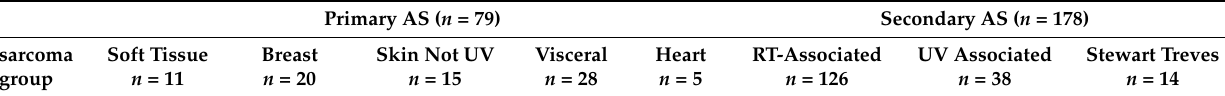
Table 3. Immune densities for all AS subgroups. Cell densities are reflected in cells/mm 2 with the IQR for all individual immune cell subclasses.